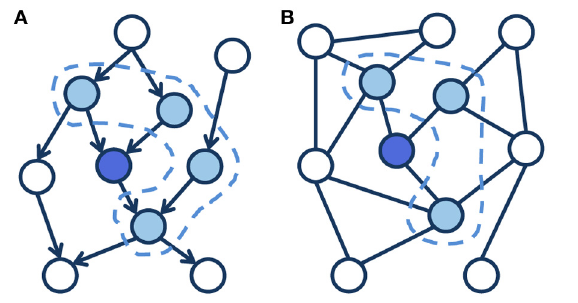
FIGURE 1 | (A) A directed graphical model, also known as Bayesian network. (B) An undirected graphical model, also known as Markov network. In both graphs, the dashed line highlights the Markov blanket of the blue